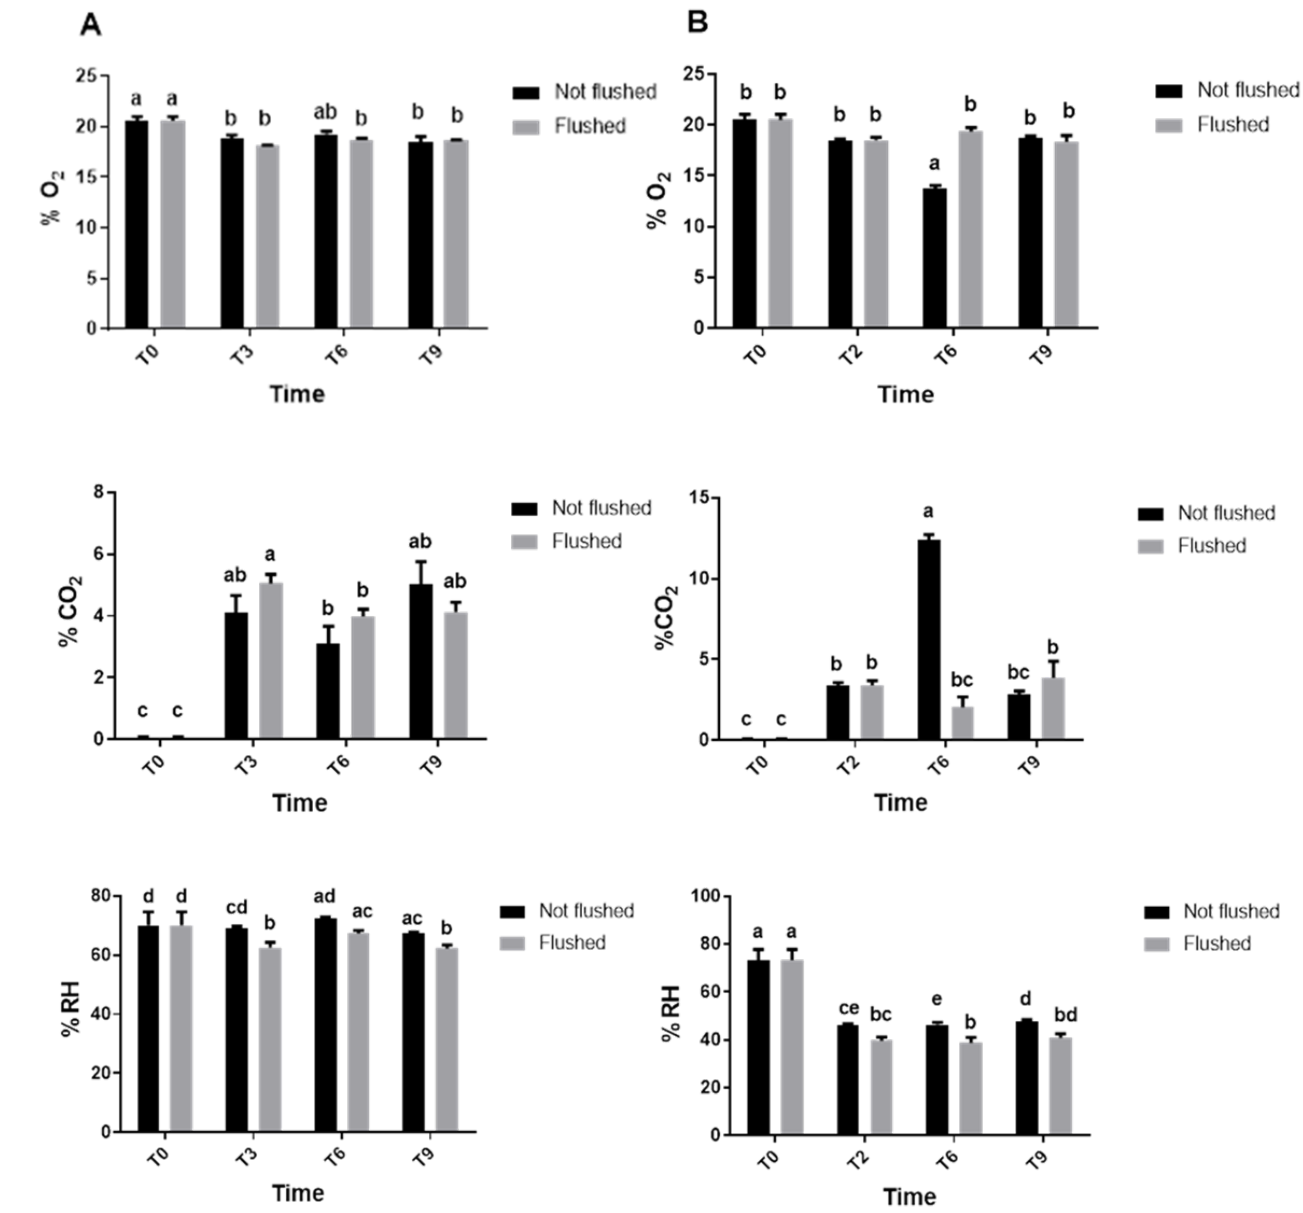
Figure 3. ( A ) CO 2 , O 2 and RH concentrations inside lettuce ( Lactuca sativa ) plastic punnets measured at harvest and three, six and nine days after harvest (data are mean ± SE, n = 4). ( B ) CO 2 , O 2 and RH concentrations inside Eruca sativa plastic punnets measured at harvest and three, six and nine days after harvest (data are mean ± SE, n = 3). Different letters represent significant differences ( p ≤ 0.05) among treatments and time points, calculated from 2-way ANOVA followed by Sidak’s test.